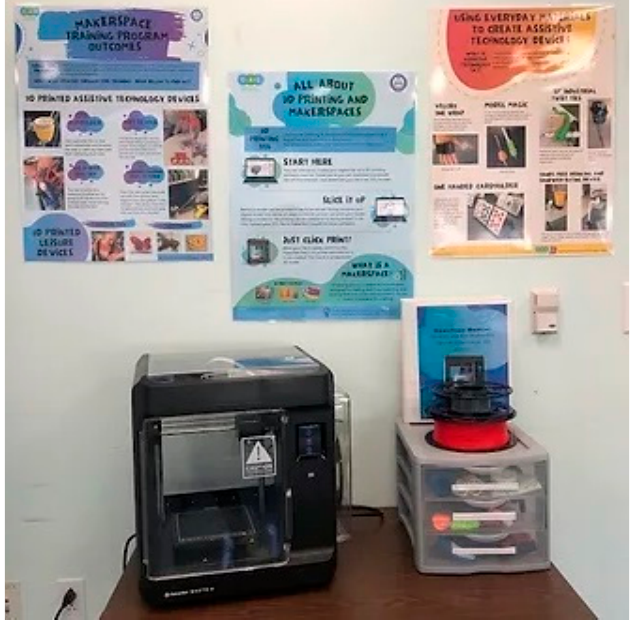
Figure 2. 3D printer from MakerBot [20], printing materials and other educational materials (the photo is taken by the authors).